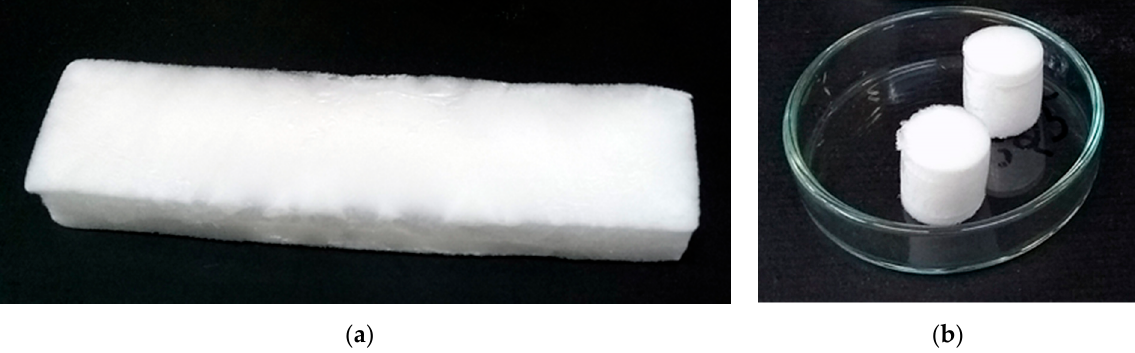
Figure 10. Photographs of freeze-dried ( a ) AOT7.25 (obtained by mold A) and ( b ) K7.25 (mold B) samples.